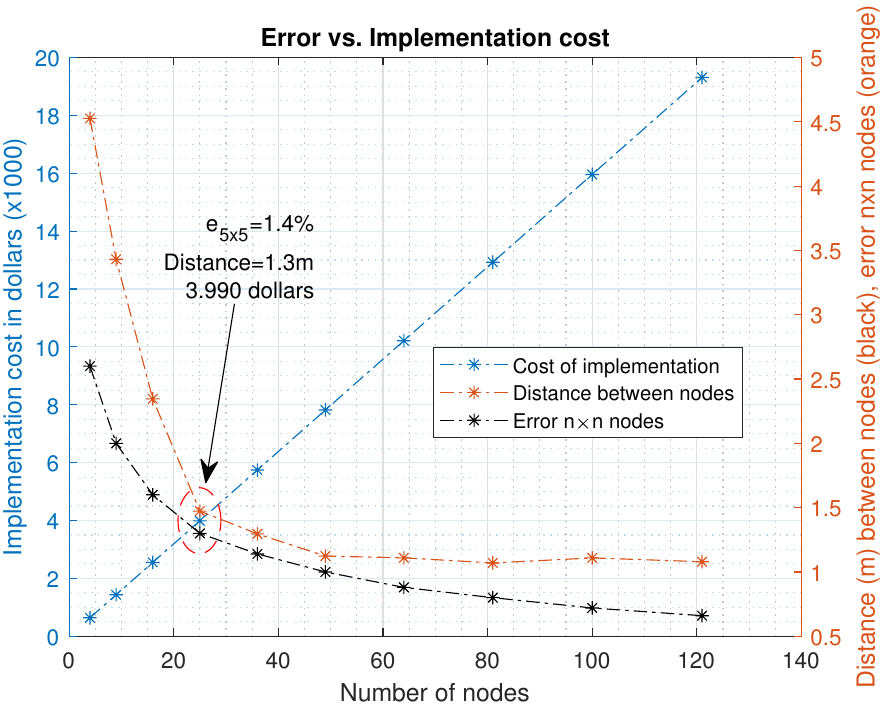
Figure 19. Relationship between the number of nodes, the cost of implementation, the error of the maps for n × n nodes and the distance between nodes for a potato crop of 8 m × 8